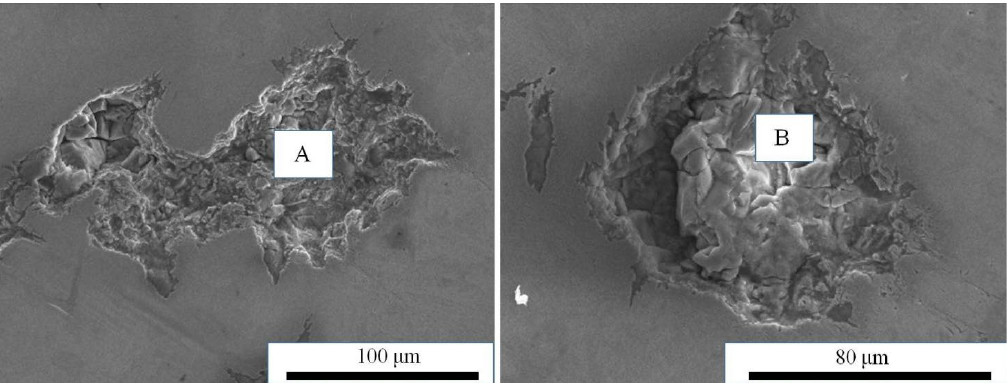
Figure 4. Effect of alloy concentration on the Gibbs free energy of oxidation at 1873 K.